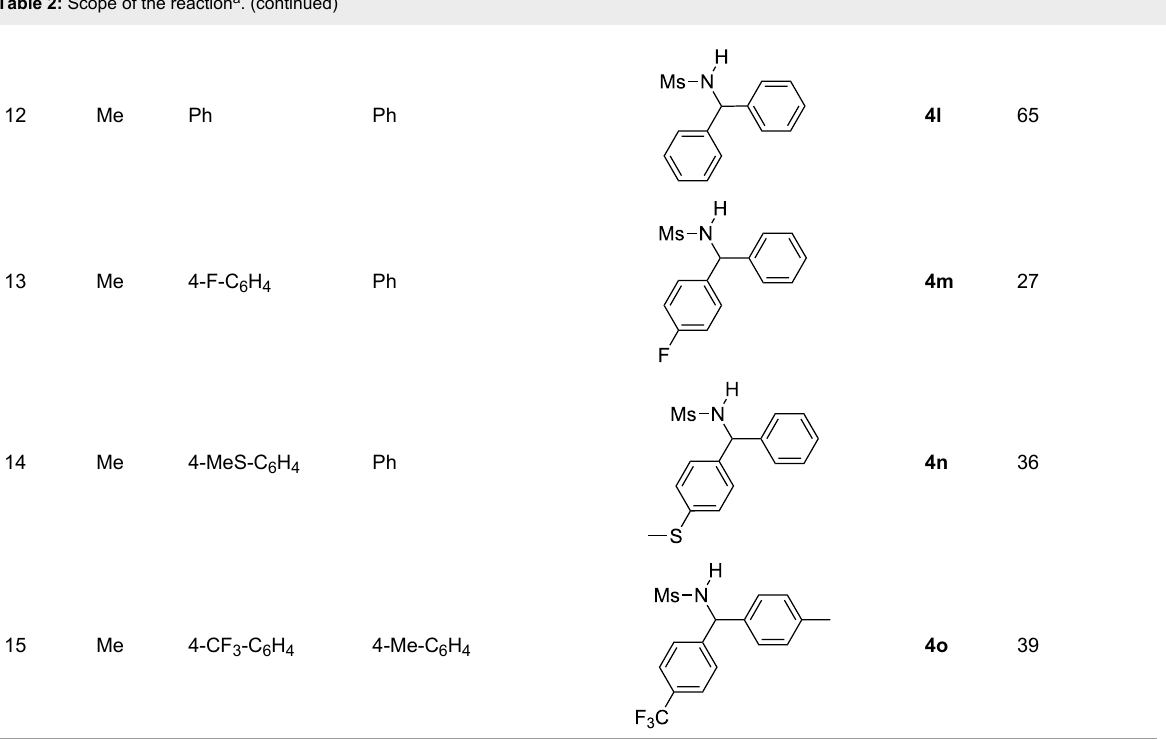
Table 2: Scope of the reaction a .